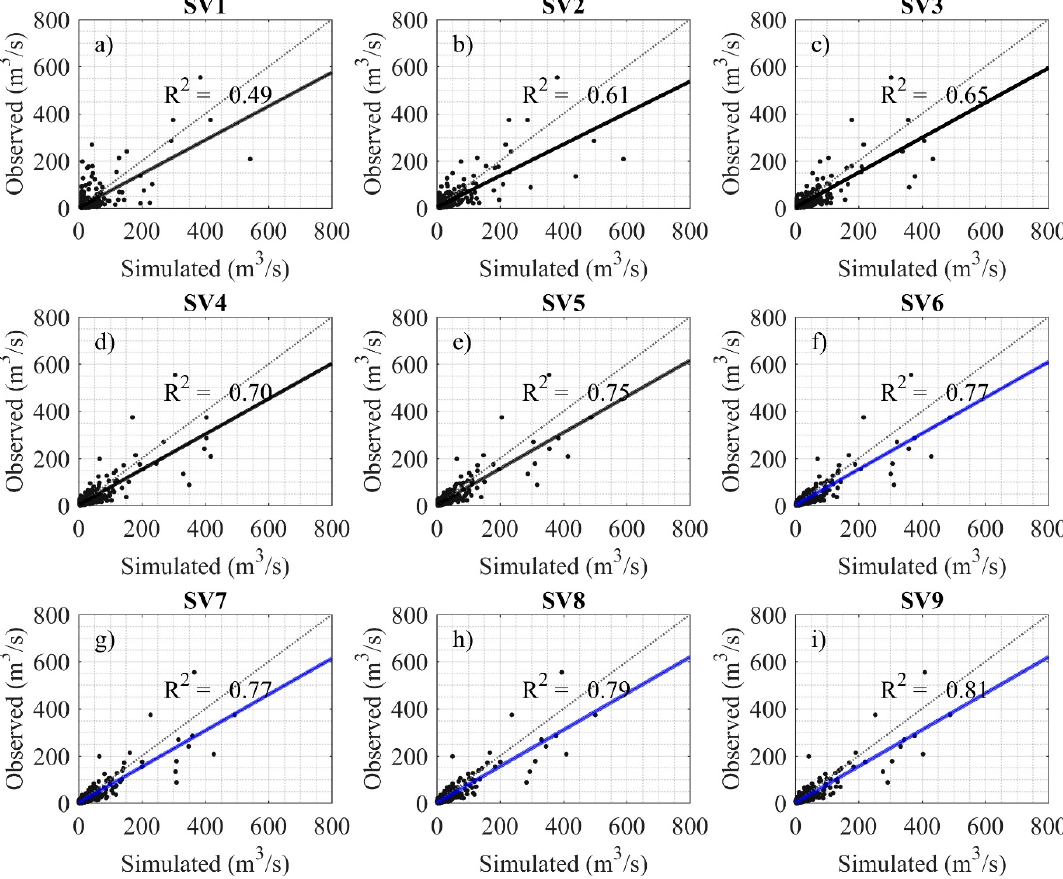
Figure 10. SV1-SV9 model scatter plots with the corresponding linear regression lines and R 2 over the testing period. Table 4. Tank-LSSVM model performance measures using di ff erent input